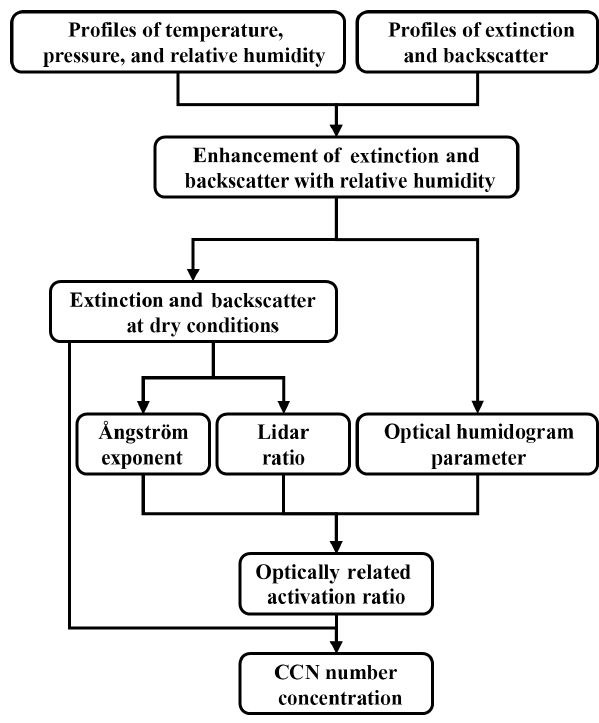
Figure 2. Schematic diagram of newly proposed method to retrieve cloud condensation nuclei number concentrations using multiwave- length Raman